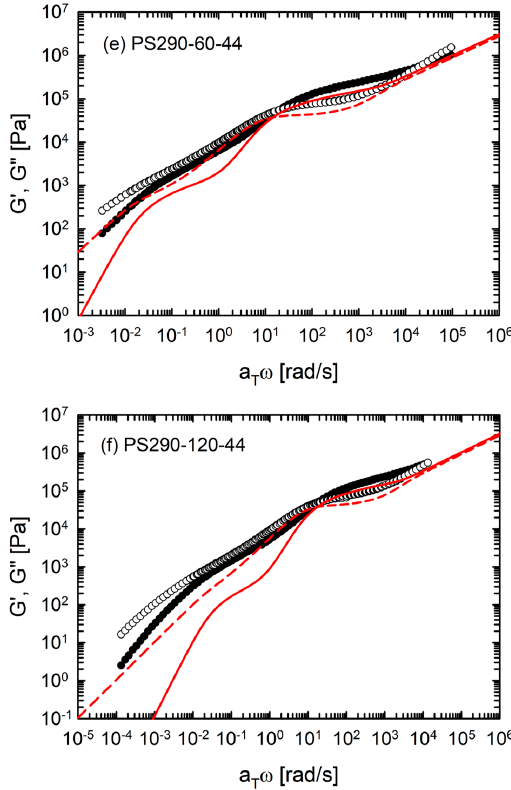
Figure 2. Comparison between experimental data and the hierarchical model predictions. ( a ) PS290, PS44 ( b ) PS290-3-44, ( c ) PS290-14-44, ( d ) PS290-30-44, ( e ) PS290-60-44 and ( f ) PS290-120-44. The symbols indicate experimental data of the model comb PS. The lines indicate the predictions of the hierarchical model.